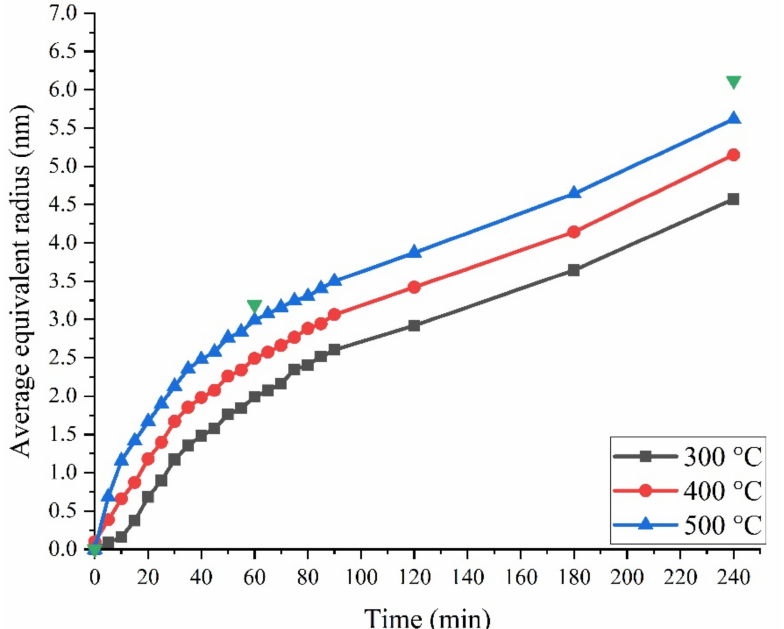
Figure 9. Plot of average equivalent radius of γ (cid:48) phase versus time for the Mn-30 at. %Cu alloy aged at 300, 400, and 500 ◦ C. The green marks represent the experimental results of Vitek and Warlimont (1976).